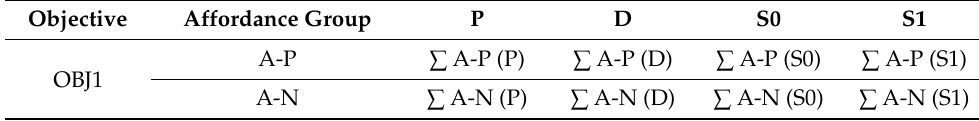
Table 4. PDS calculation for Positive Index (PI) and Negative Index